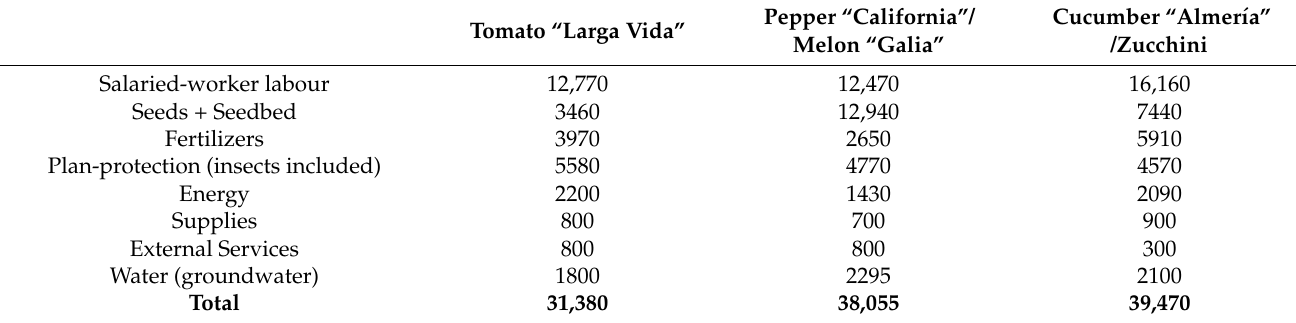
Table 5. Variable Costs of an Agricultural Holding (per hectare) *.